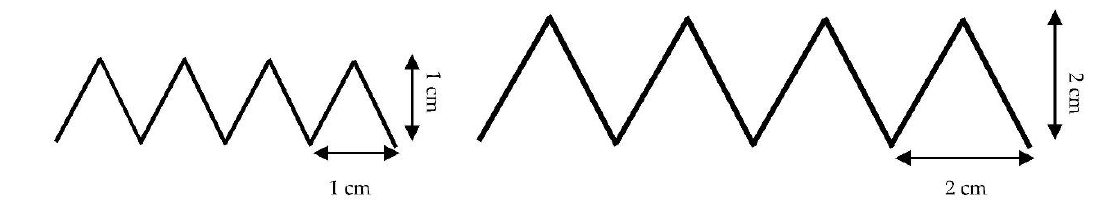
Figure 3. A schematic of the 1 × 1 cm (left) and 2 × 2 cm (right) V-shaped cardboard substrates.